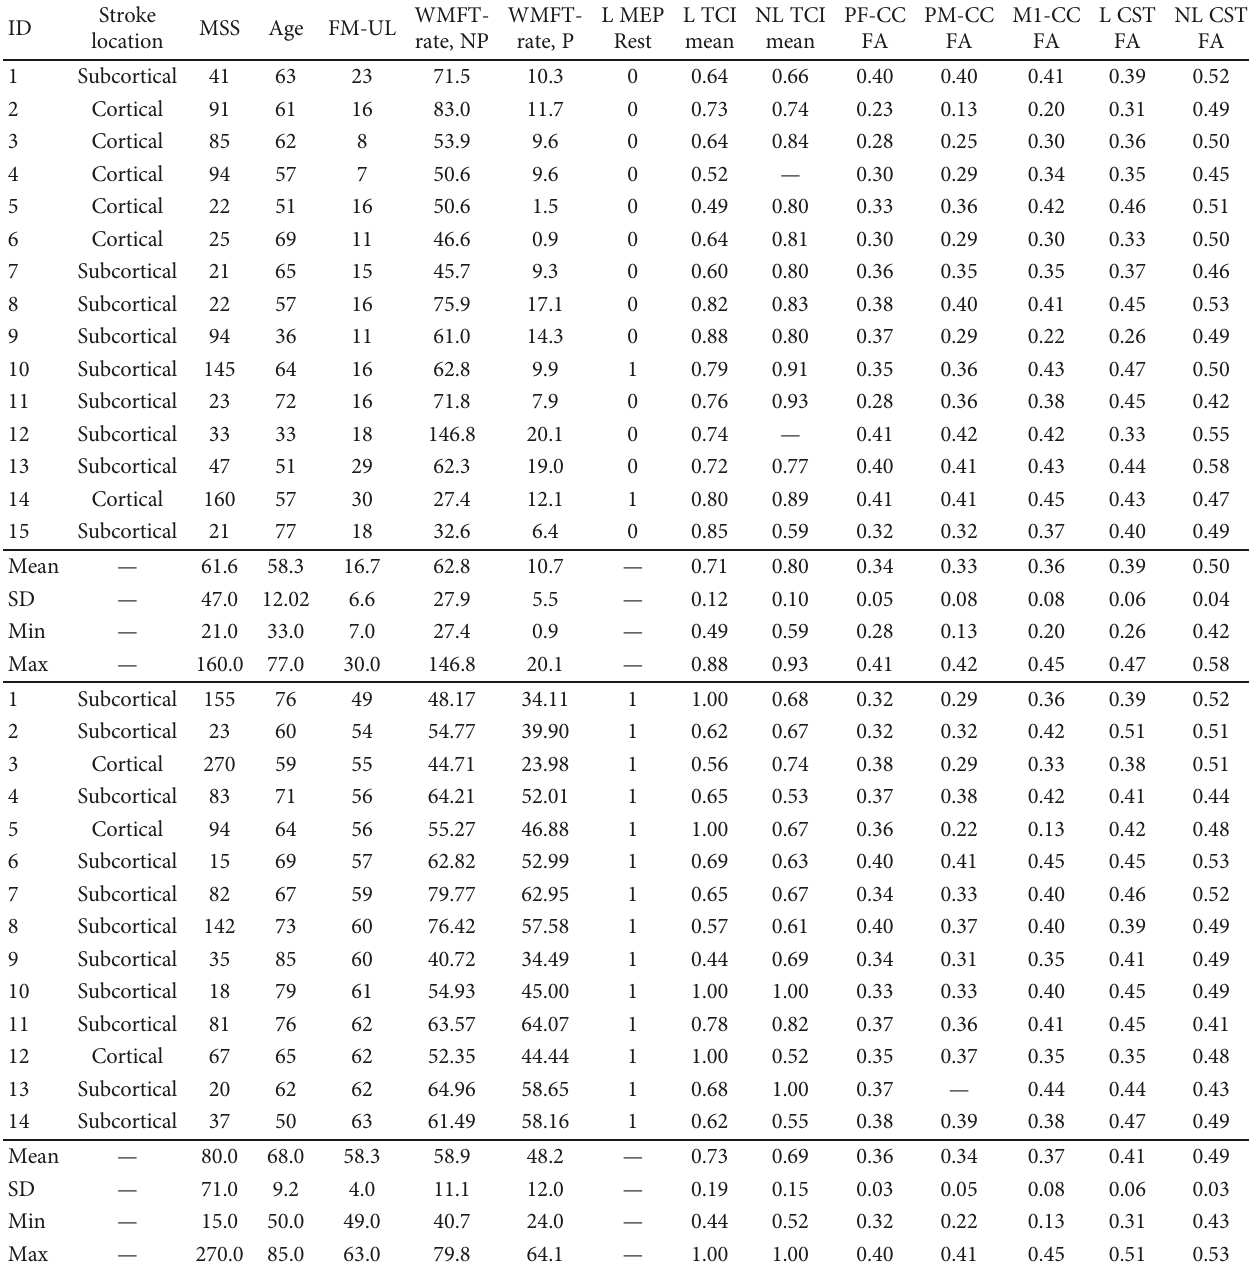
Table 2: Individual participant demographics and stroke